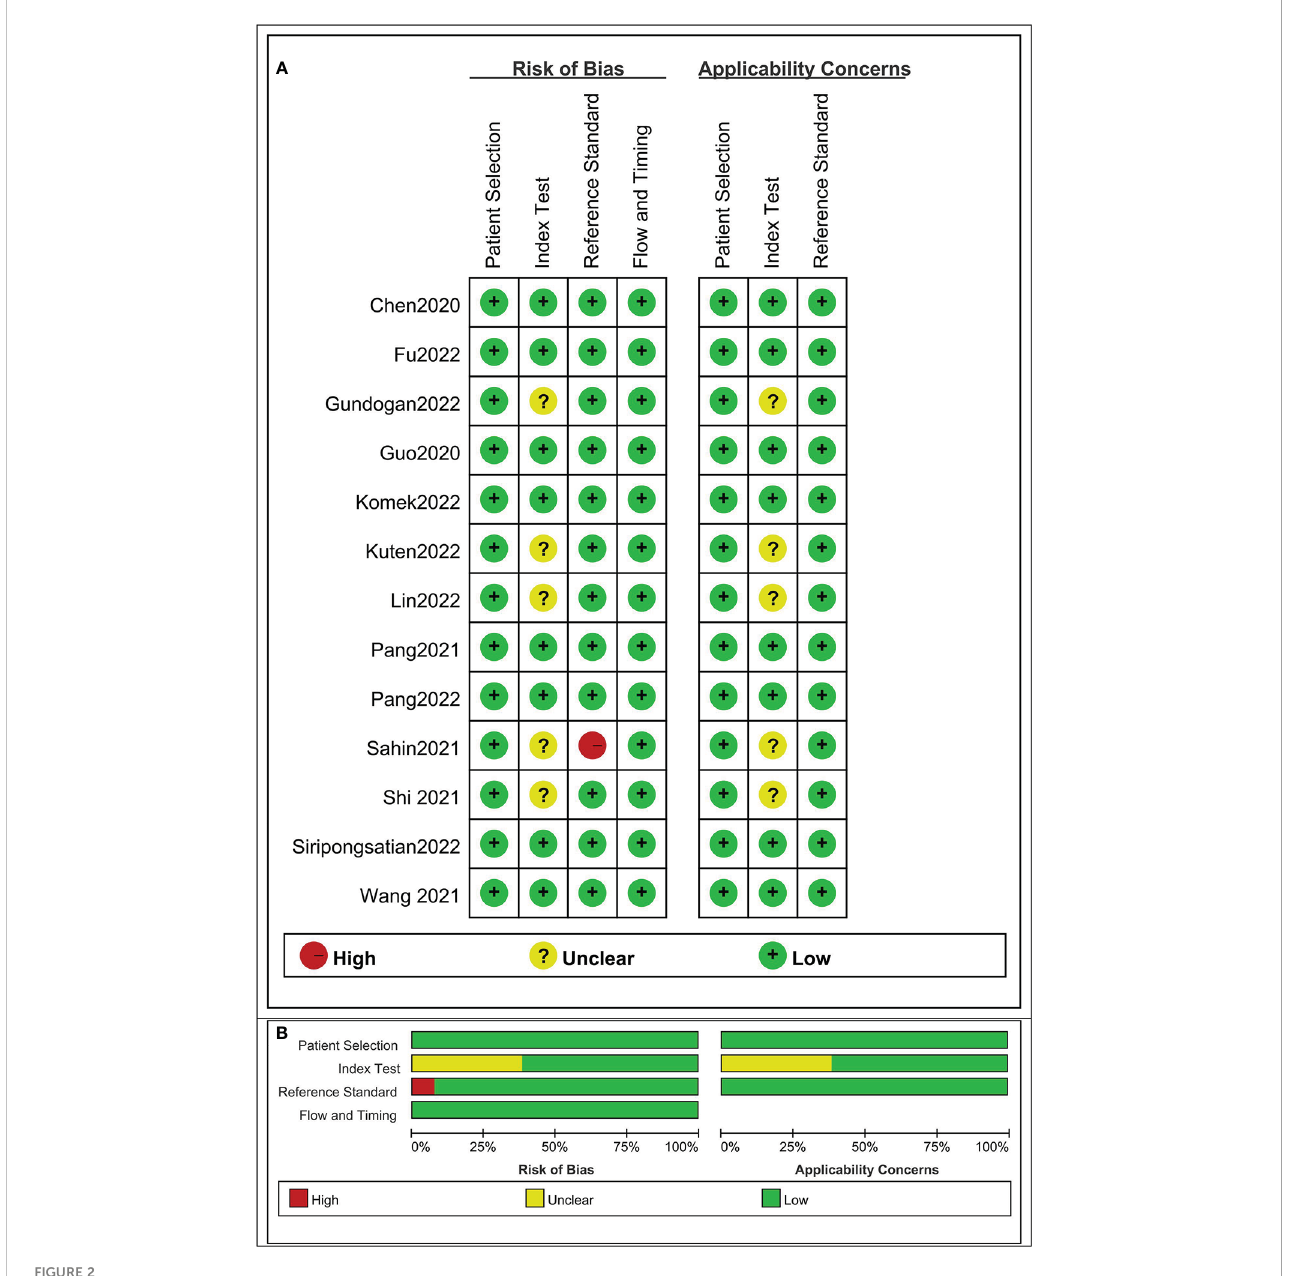
FIGURE 2 Risk of bias and applicability concerns the summary (A) and graph (B) of the studies included in the systematic review according to the QUADAS-2 tool. Overall quality of the included studies was deemed